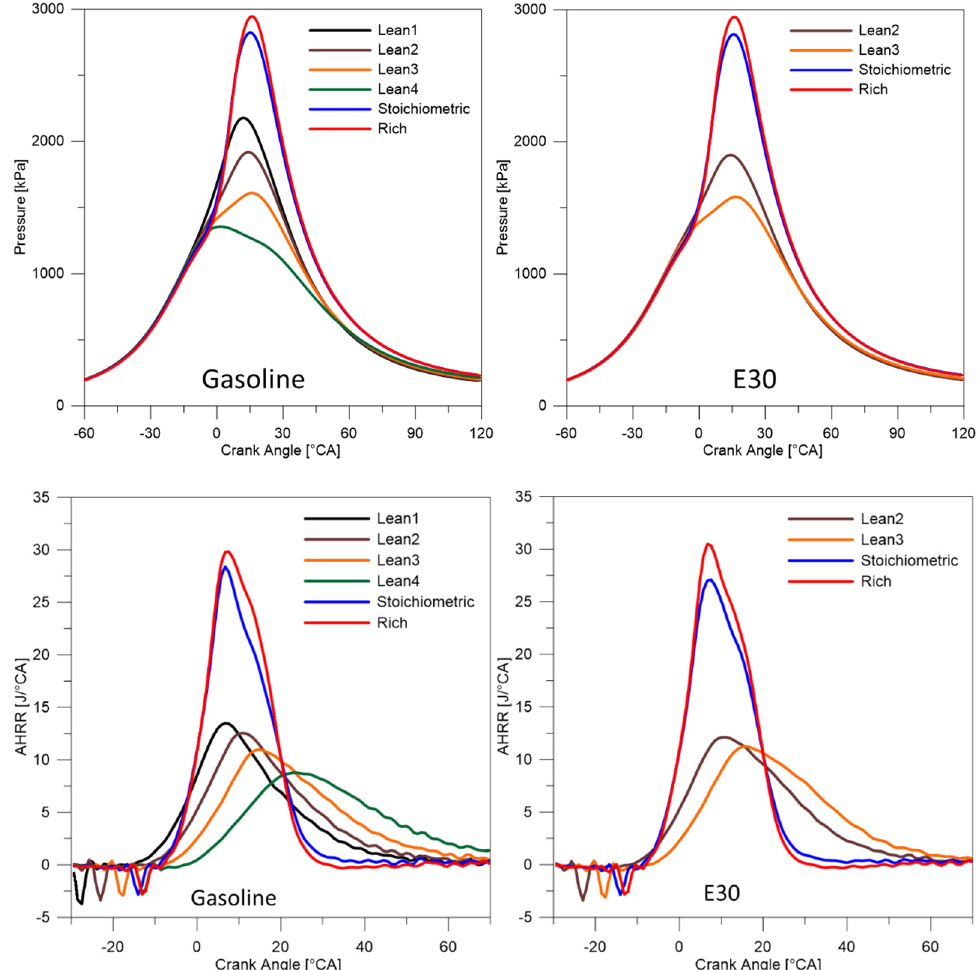
Figure 6. Pressure traces (top) and the rates of heat release (bottom) for gasoline (left) and E30 (right) for all the selected well-mixed conditions. The negative AHRR dips before combustion is caused by noise generated by the initial spark discharge, therefore indicating the spark timing for each case.